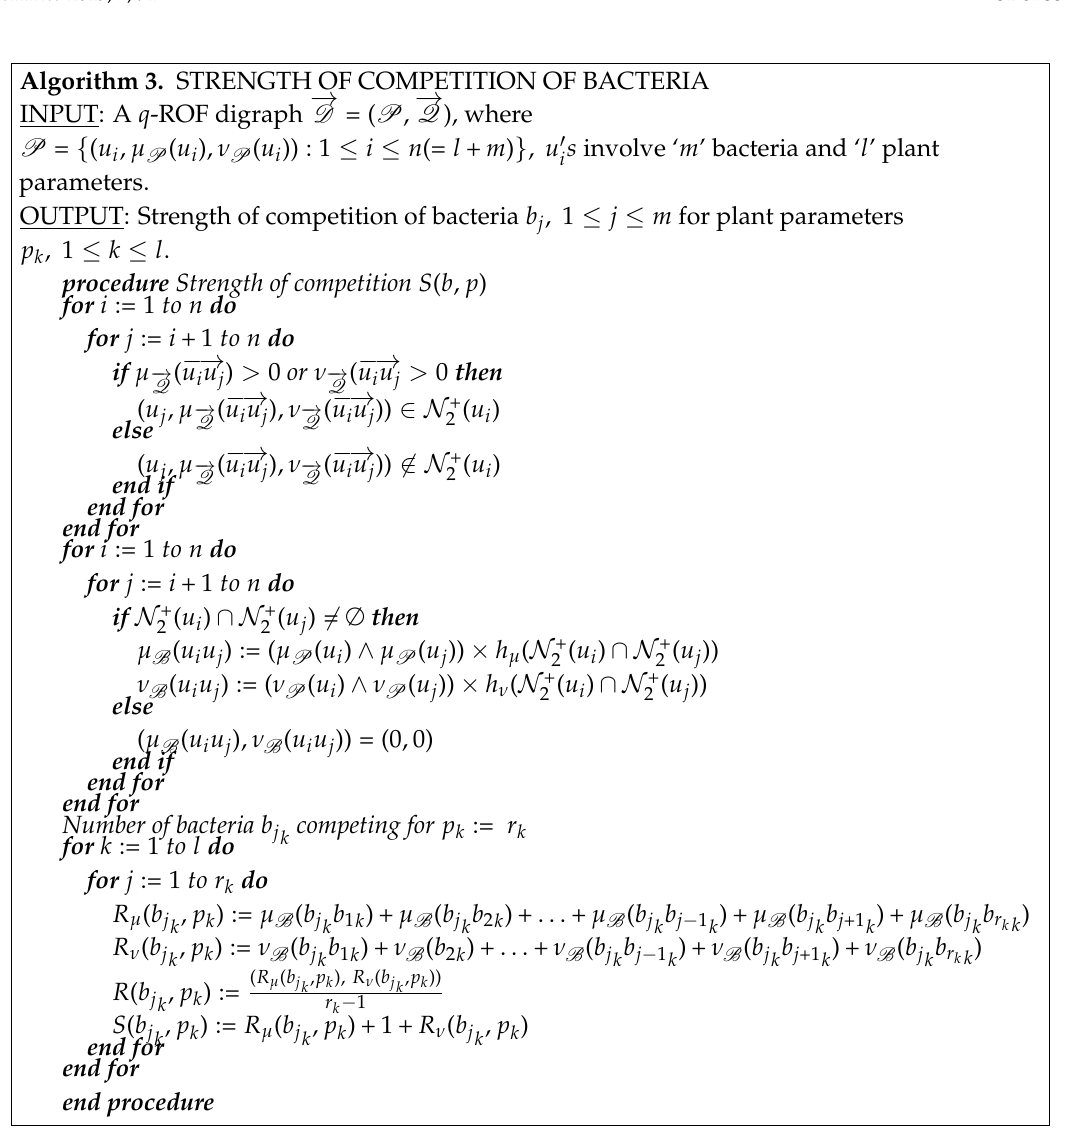
Algorithm 3. STRENGTH OF COMPETITION OF